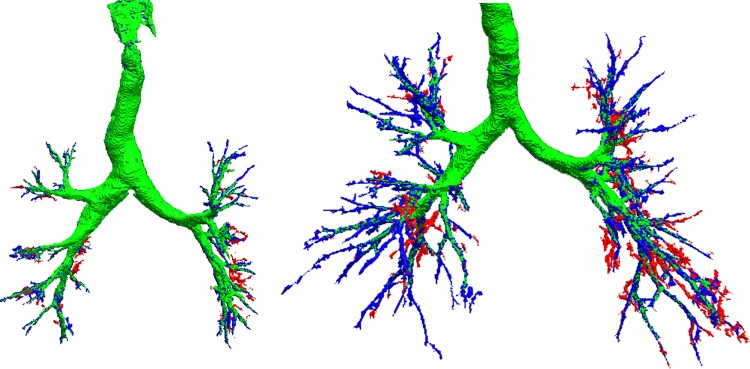
EXACT09: Performance of PICASSO in terms of leakage suppression (red voxels) and branch detection with varying complexity (complexity 0, green voxels; complexity 0.15, blue voxels).Case 24 in the left panel and case 34 in the right one.